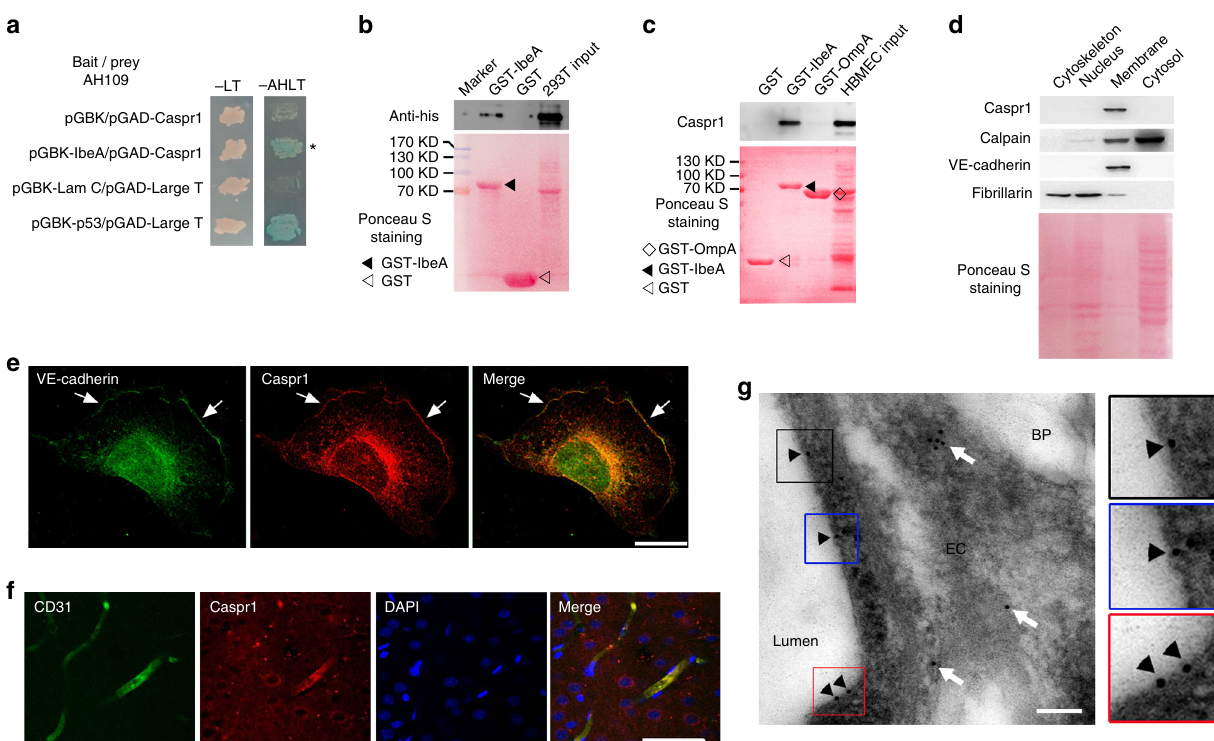
Fig. 1 Endothelial Caspr1 is identi fi ed as the binding protein of bacterial IbeA. a Yeast cells co-transformed with bait and prey plasmids were grown on SD/-Leu-Trp (-LT) selection medium and SD/-Ade-His-Leu-Trp (-AHLT) medium containing X- α -Gal. Co-transformation of Lamin C and Large T served as a negative control, whereas p53 and Large T was a positive control. b HEK293T cells were transfected with His-tagged full-length Caspr1, then the cell lysates were prepared and co-incubated with the beads prebound with GST-IbeA for GST pulldown assay, with GST as control. The precipitates were analyzed by western blot using His antibody (upper). Full blots are shown in Supplementary Fig. 8. The blotting membrane was stained with Ponceau S as a loading control (lower). c HBMECs were lysed and co-incubated with the beads prebound with GST-IbeA for GST pulldown assay, with GST and GST-OmpA as controls. The precipitates were analyzed with Caspr1 antibody (upper). Full blots are shown in Supplementary Fig. 8. The blotting membrane was stained with Ponceau S as a loading control (lower). d Subcellular components of HBMECs were extracted and analyzed by western blot with antibodies recognizing Caspr1, Calpain (cytosolic marker), VE-cadherin (membrane marker), and Fibrillarin (nucleus marker), respectively (upper). Full blots are shown in Supplementary Fig. 8. The blotting membrane was stained with Ponceau S as a loading control (lower). e HBMECs were fi xed and immuno fl uorescence was performed with antibodies recognizing Caspr1 (Red) and VE-cadherin (Green). Arrows indicate the co-localization of Caspr1 with VE-cadherin. The expression of VE-cadherin in the nuclear fraction was undetectable in ( d ), thus we consider the fl uorescence signals of VE-cadherin in the nucleus might be caused by non-speci fi c staining. Scale, 50 μ m. f The rat brain slices were prepared and stained with Caspr1 (Red) and CD31 (Green) antibodies. DAPI was used to identify nuclei (blue). Scale, 50 μ m. g Ultra-thin sections were prepared from the rat brain and labeled with primary antibody recognizing Caspr1, followed by incubation with secondary antibody conjugated with 10-nm gold particles. Images were acquired using transmission electron microscope. EC: endothelial cell, BP: brain parenchyma, Lumen: vascular lumen. Arrowheads indicate labeling of Caspr1 in the luminal side of endothelial cell whereas arrows indicate intracellular labeling. Scale, 100 nm. The zoom-in windows of the positive labeling of the luminal Caspr1 were provided (right). All the images are representative of three independent